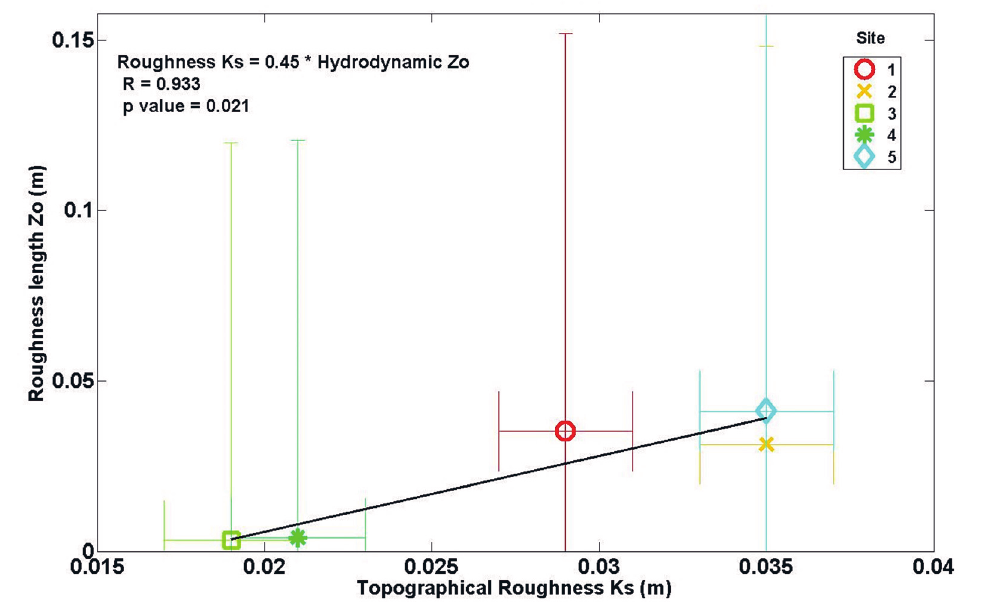
Figure 10. Correlation between the roughness length Zo and the topographical roughness Ks defined as 2*STD + skin